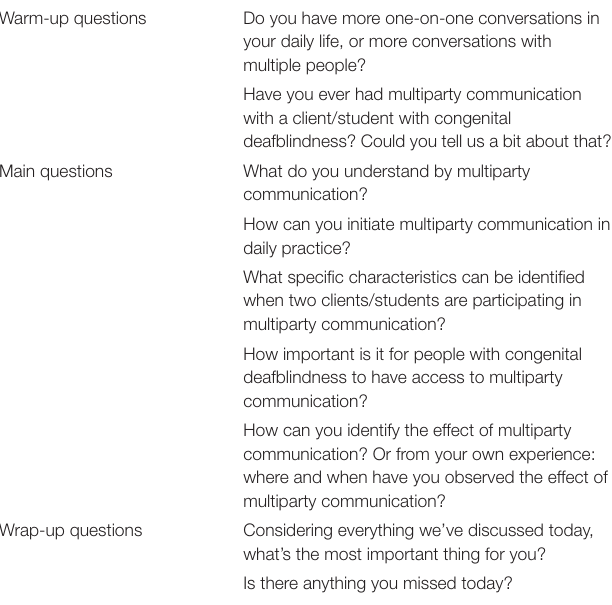
TABLE 1 | Guiding questions used in focus group sessions. Warm-up